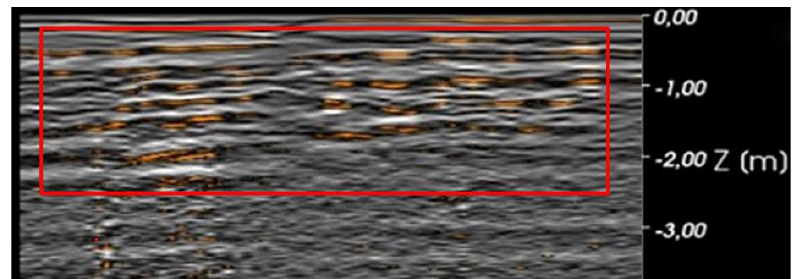
Figure 9. Radargram corresponding to the disturbance highlighted in red in Figure 8.